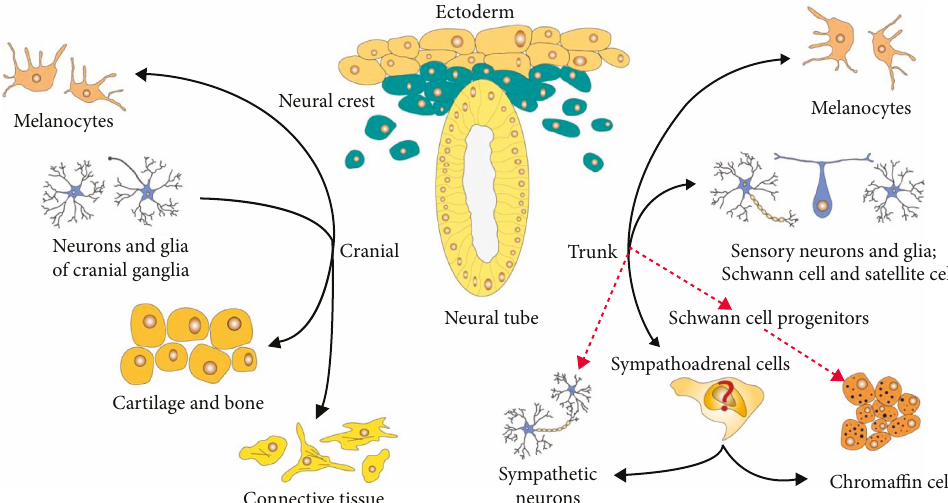
Figure 1: Cell types of neural crest